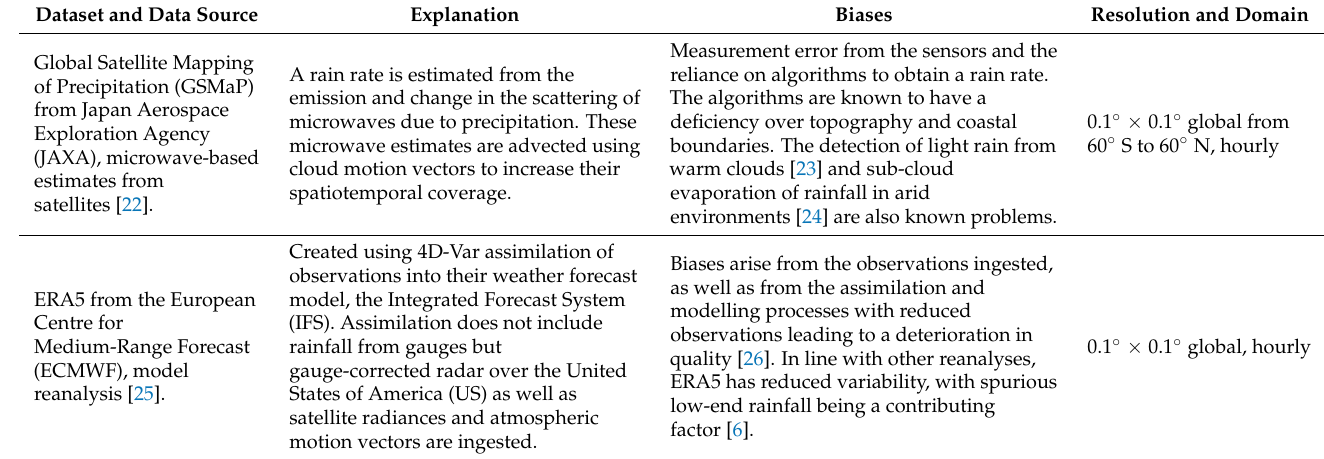
Table 1. Details on datasets used in this study for creation of the blended dataset, as well as fo